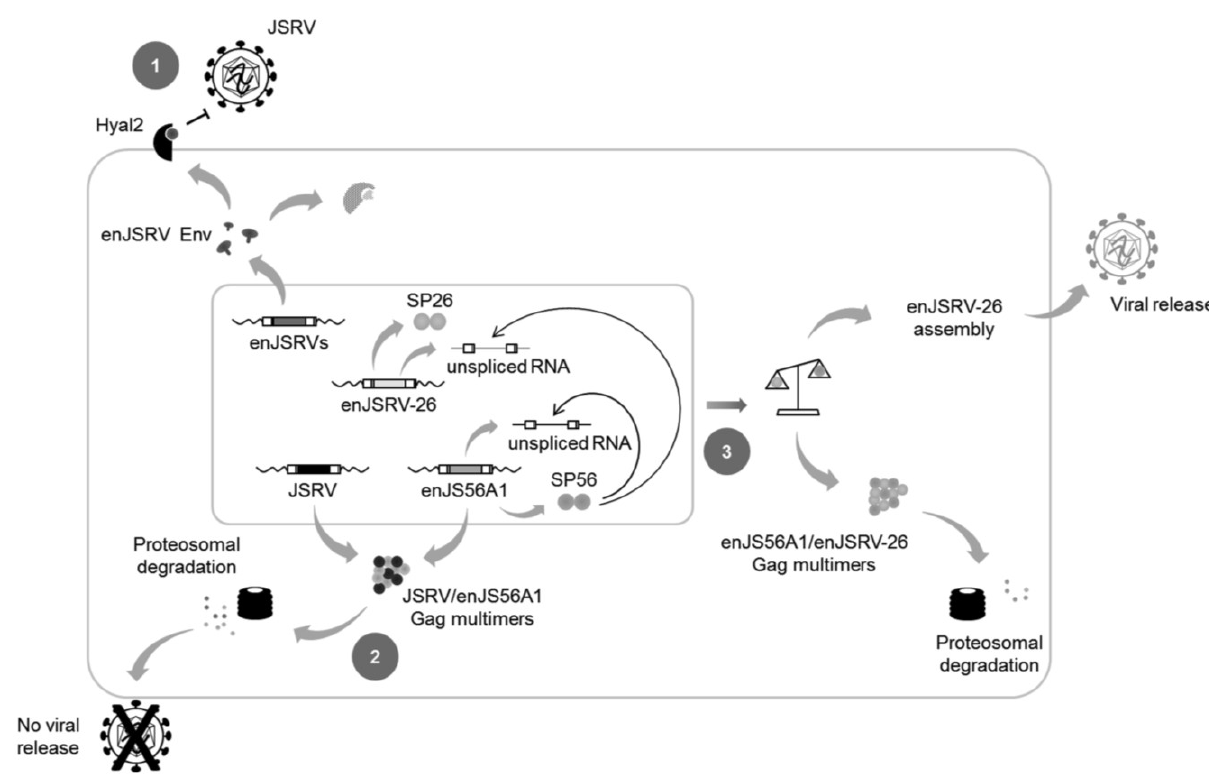
Figure 4. Mechanisms of restriction induced by enJSRVs, and JLR escape. enJSRVs can inhibit JSRV entry at the cell entry by receptor interference, as both endogenous and exogenous retroviruses use Hyal2 as cellular receptor. The binding between enJSRVs Env and Hyal2 (either at the plasma membrane or in the cytoplasm) decreases the availability of the latter at the cell surface, thereby inhibiting JSRV entry into target cells (1); In addition, some enJSRVs, such as enJS56A1, can block JSRV at post-integration steps of viral cycle. This mechanism of interference, known as JLR, most likely impairs viral